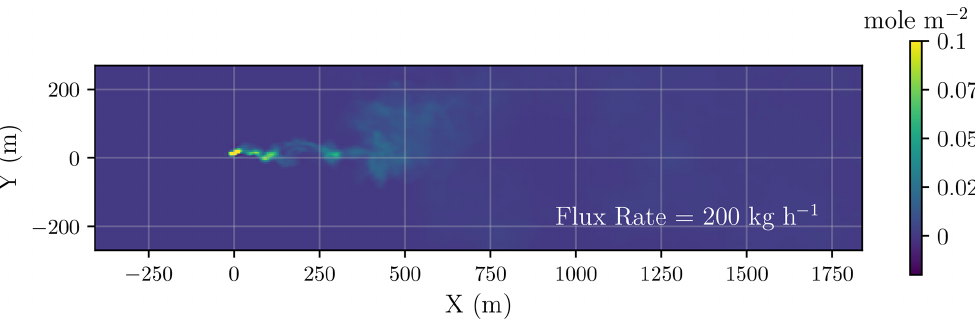
Figure 11. A nadir view of a simulated CH 4 plume from the LES with a prescribed flux rate of 200kgh − 1 . The background wind speed is 4m/s − 1 along the x axis.